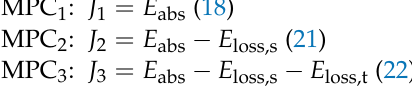
Figure 10. Average absorbed power versus time step for 5 s prediction horizon for three sea states.